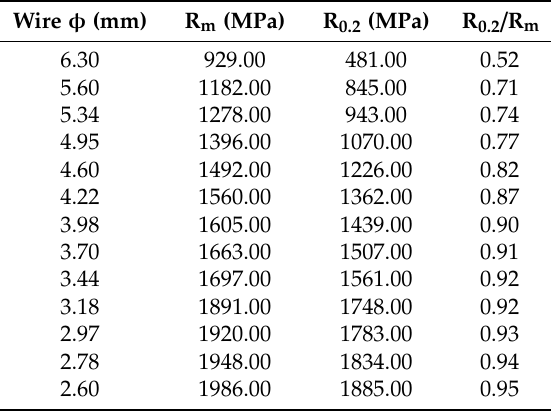
Table 4. Results of tests regarding the mechanical properties of TRIP steel wires drawn as per variant A (V c = 1.6 m / s, low single drawing